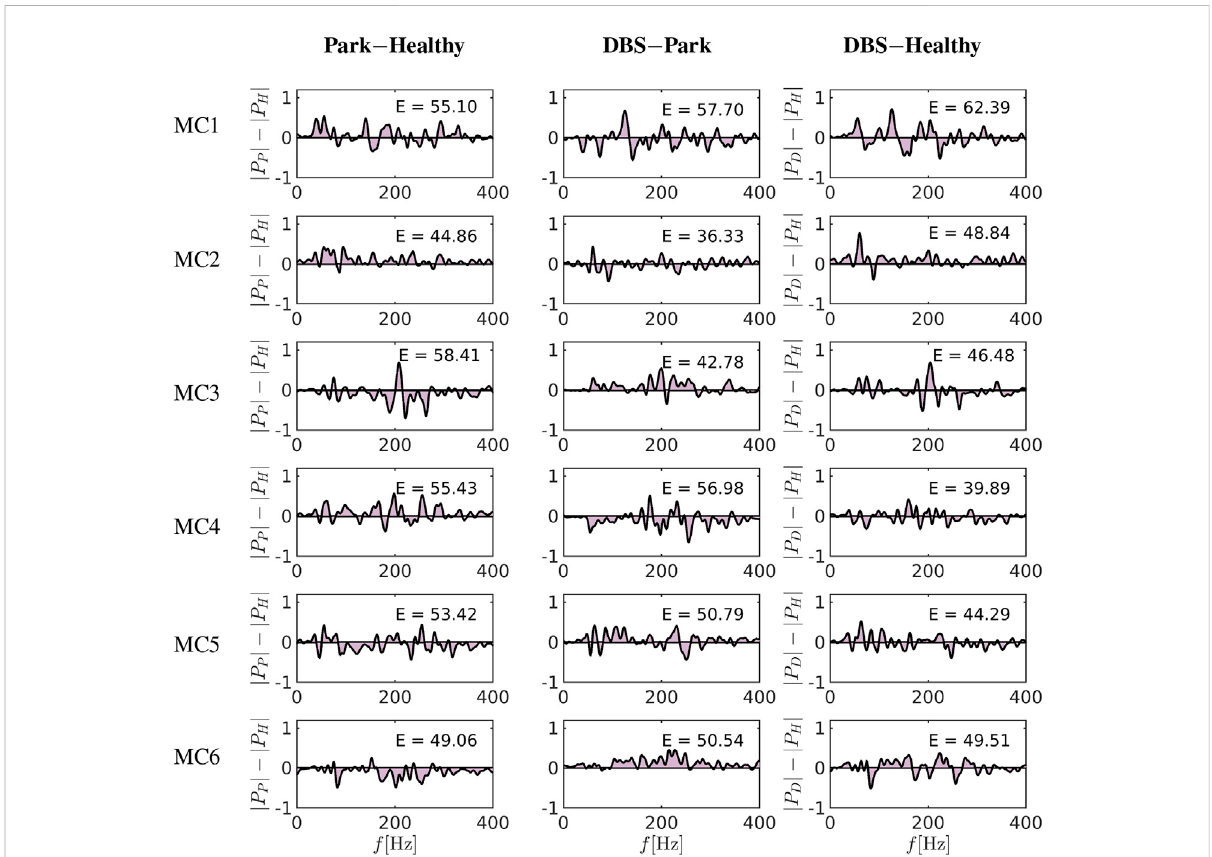
FIGURE 8 Differences of the spectrum between Park-Healthy and DBS-Healthy [subtracting the spectrum according to Eq. 23]. Each row represents one of six cortical sets of nodes as emergent from centrality measure modelling. The columns show the differences of these frequency spectra by subtracting Park vs. Healthy, DBS vs. Park and DBS vs. Healthy. The shaded area under the curve as a measure of frequency spectrum divergence is computedand depictedincolumns 1,2and 3.TheMC3, MC4 andMC5areasinthecasesofDBSvs.Healthy show areductioninthecomputed area compared to Park vs. Healthy, indicating that DBS reduces the spectrum difference compared to Parkinsonian condition, although differences to the healthy condition